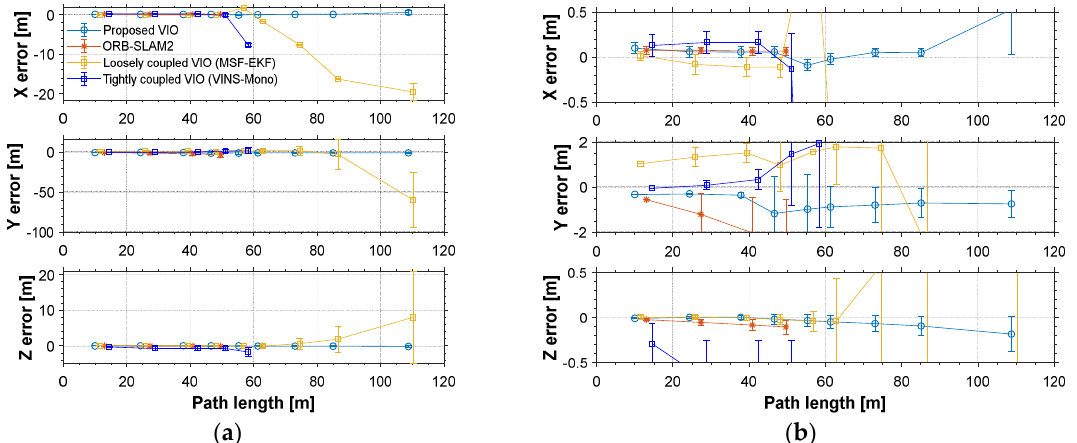
Figure 14. ( a ) The value of mean error and root mean square error (RMSE) of motion estimation from different methods. ( b ) An illustration of partial enlargement.